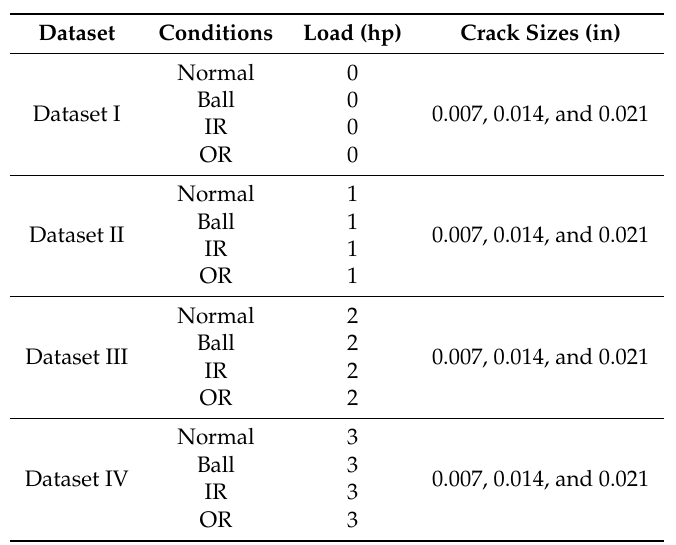
Table 1. The Case Western Reserve University (CWRU) datasets to test the activity of the proposed algorithm in normal and abnormal bearing